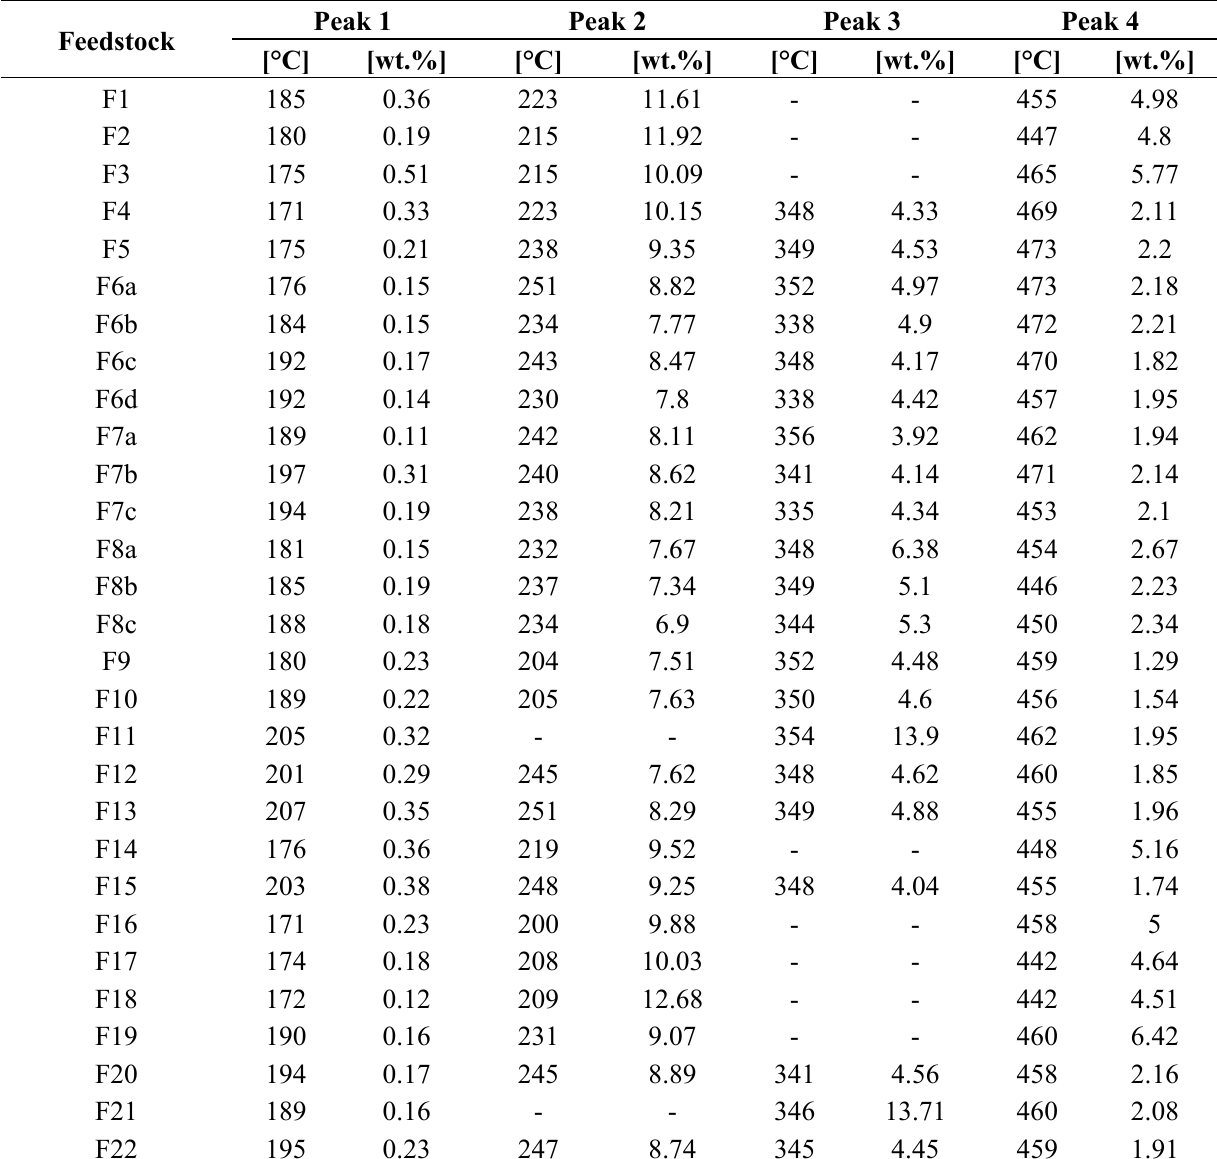
Table 3. Feedstock thermal degradation peaks in percentage of weight